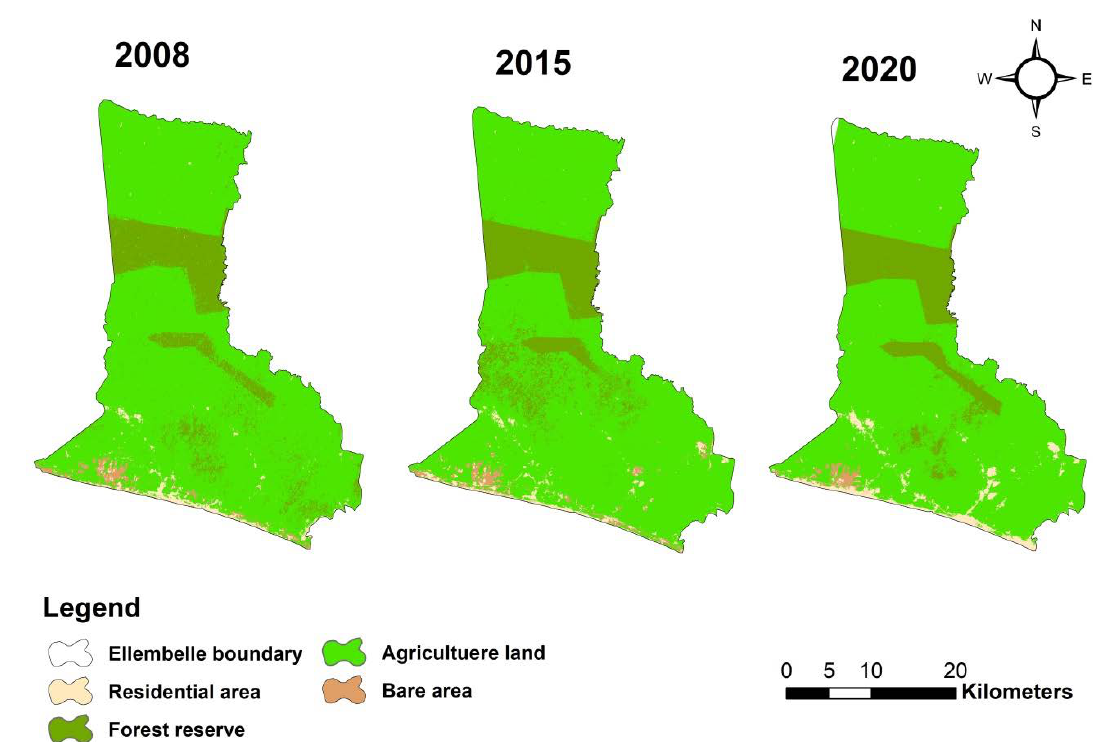
Figure 7. LULC classified images of the study area for 2008, 2015, and 2020.